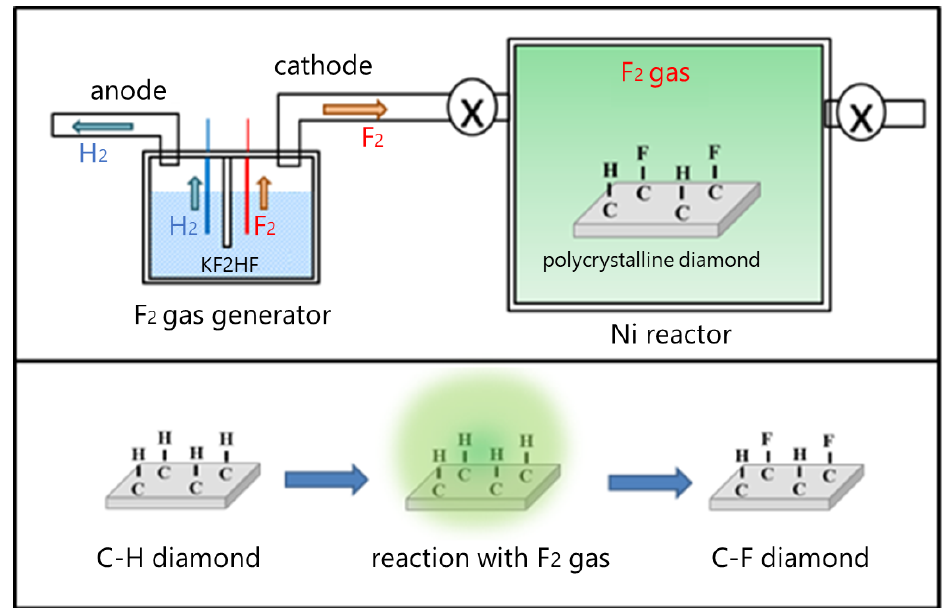
Figure 1. Schematic diagram of the process of fluorine gas (F 2 gas) direct treatment.